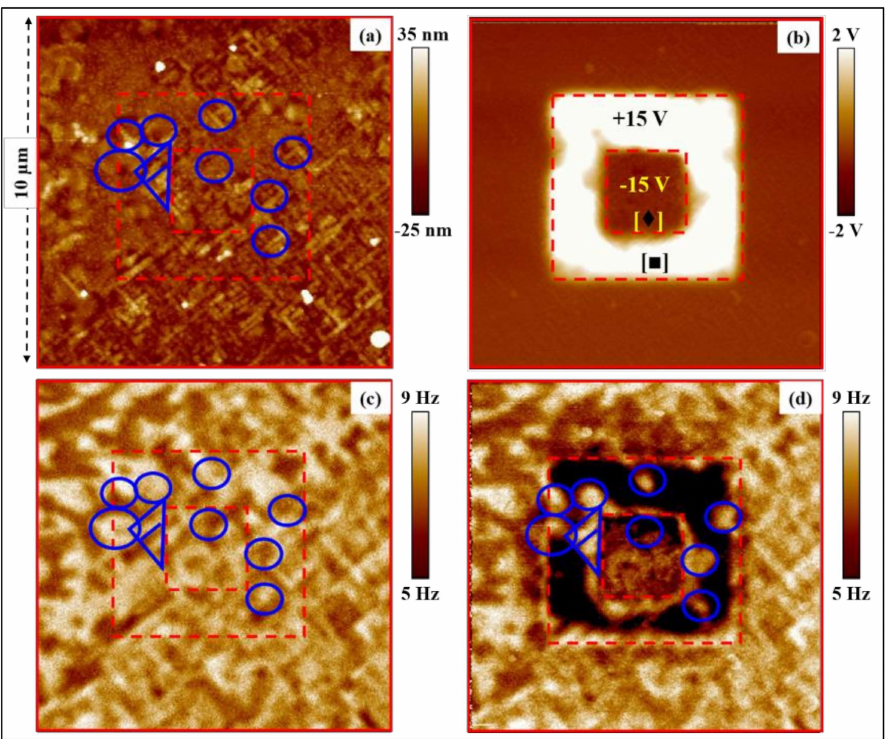
Figure 7. The influence of an applied voltage on the magnetic domains of the TTB-Eu/BaFO het- erostructure after poling 5 × 5 µ m 2 with +15 V, then 2 × 2 µ m 2 with − 15 V (see dotted contours). ( a ) Topography of surface of TTB-Eu/BaFO heterostructure. ( b ) Surface potential (KPFM) image, having the additional benefit of compensating for the electrostatic effects that could be present during the MFM measurements (see text). ( c , d ) are the MFM images, i.e., represent the magnetic response (frequency shift) of the heterostructure, respectively, before and after applying the DC electric poling excitation of ± 15 V. The regions marked with blue circles and triangles show changed magnetic contrast. [ (cid:4) ] and [ (cid:7) ] indicate regions with a negative and a positive frequency shift,